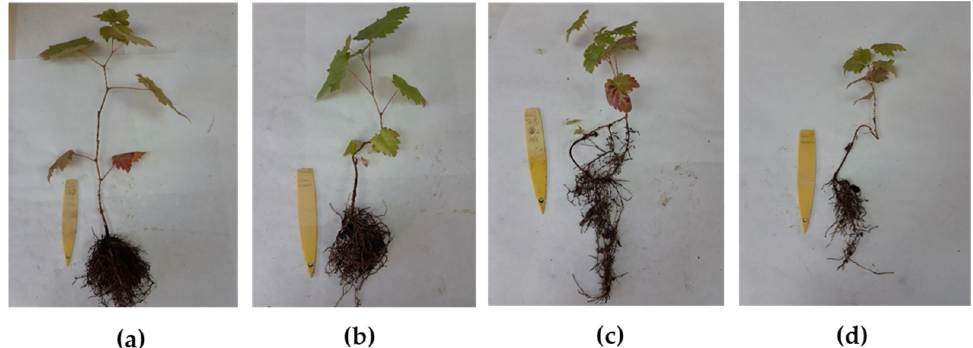
Figure 3. Growth promotion effects of Trichoderma strains: ( a ) control seedling inoculated with T. harzianum 2; ( b ) control seedling inoculated with T. harzianum 1; ( c ) control seedling inoculated with T. harzianum 5 ; ( d ) control seedling not inoculated.